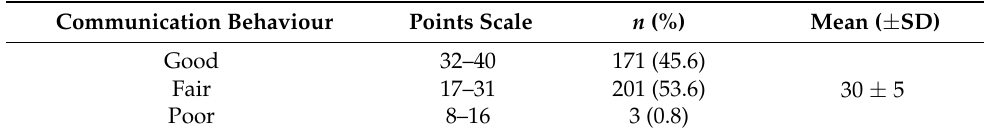
Table 3. Distribution of participants based on levels of communication.